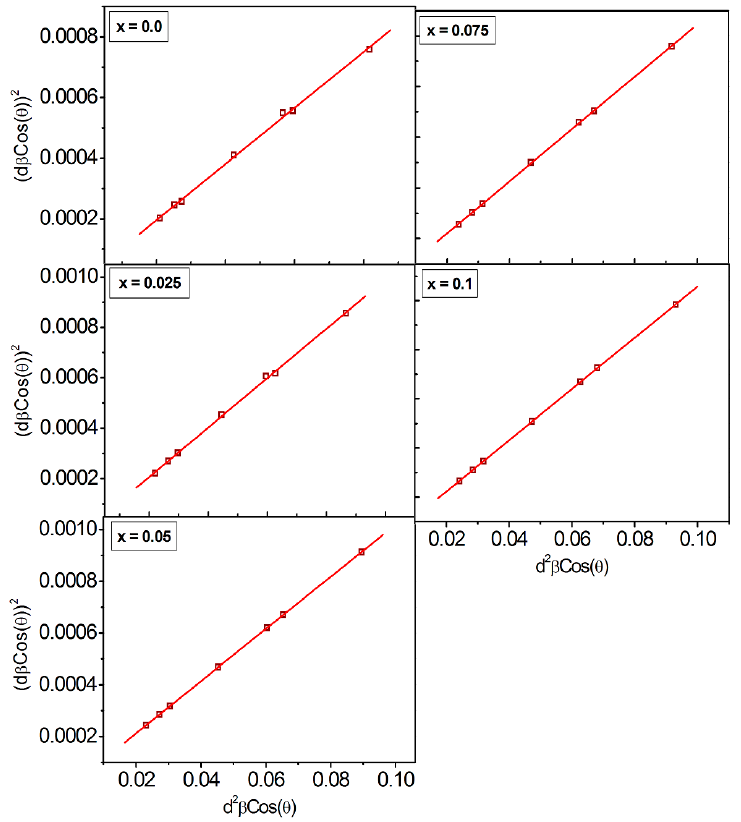
Figure 4. Size—strain plots of CoCr 0.5 Dy x Fe 1.5-x O 4 .